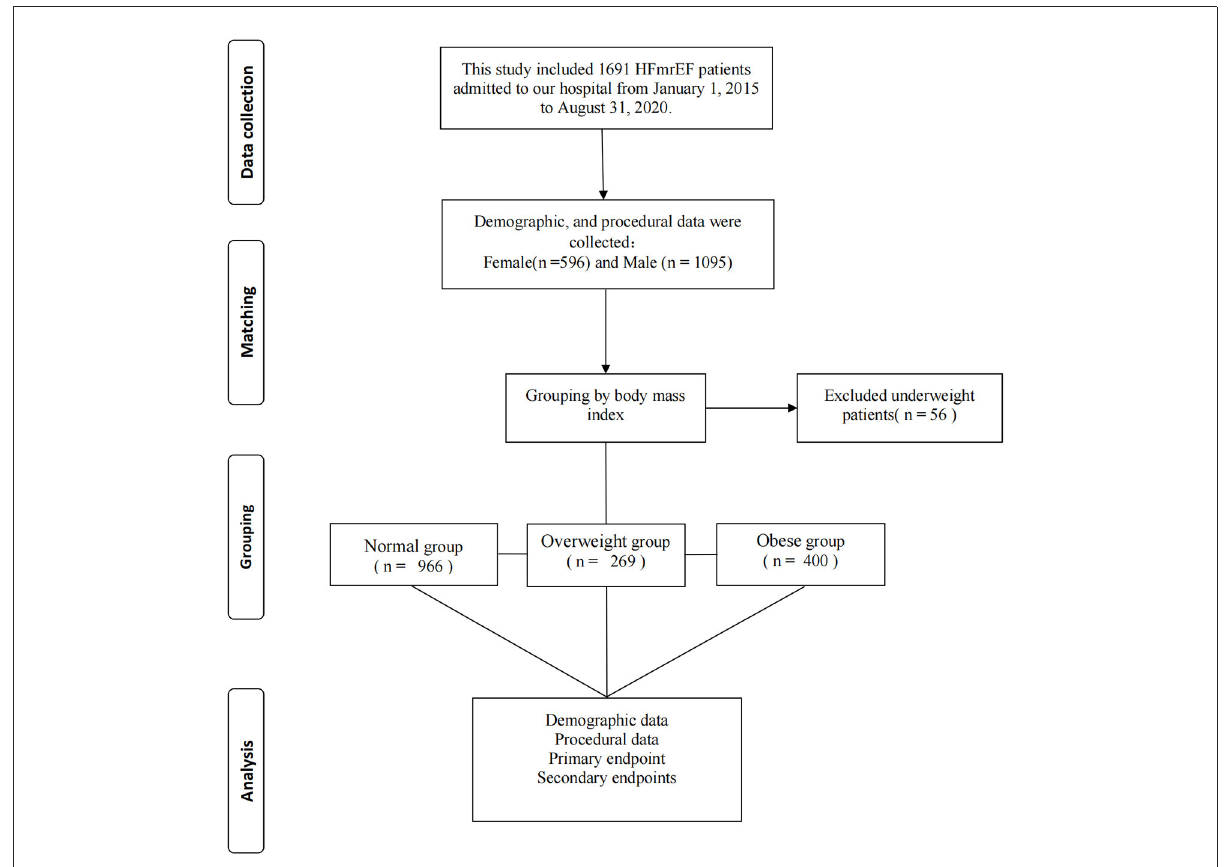
FIGURE1 Flow diagram for participant screening, eligibility and